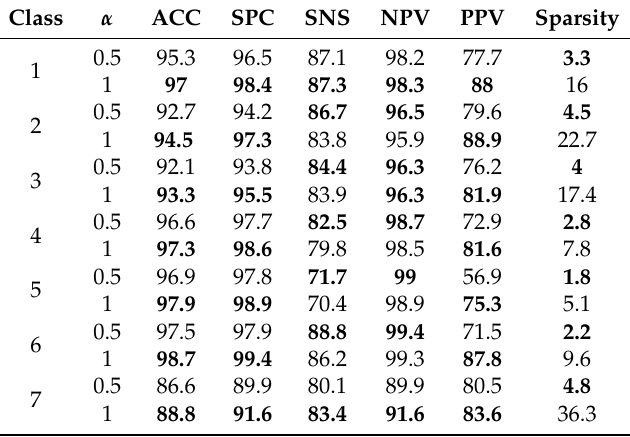
Table 2. Average results (in percentage) on Test Set for (cid:96) 1 -SVM. In bold, the best between the two fitness function tradeoff values for α .